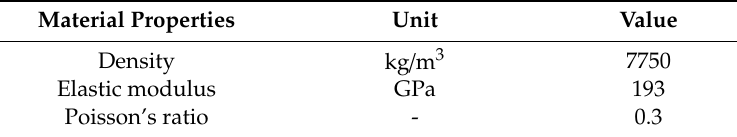
Table 2. Material properties of the stainless steel beam.